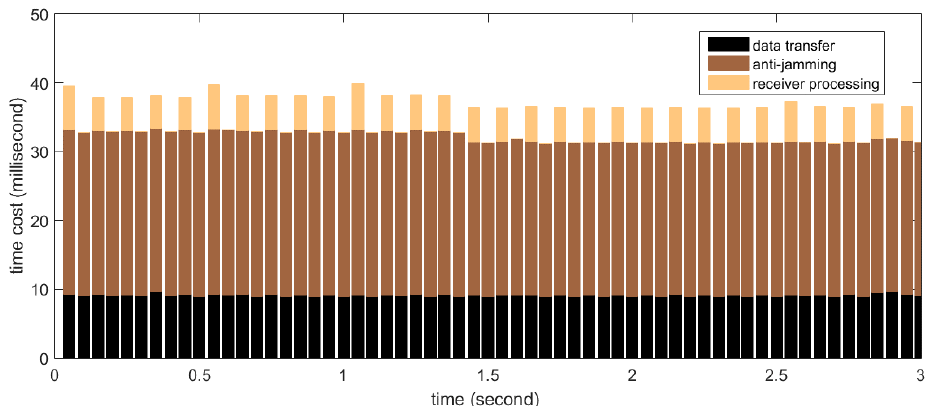
Figure 15. Time cost distribution for real-time processing with the space-time adaptive processor (STAP).